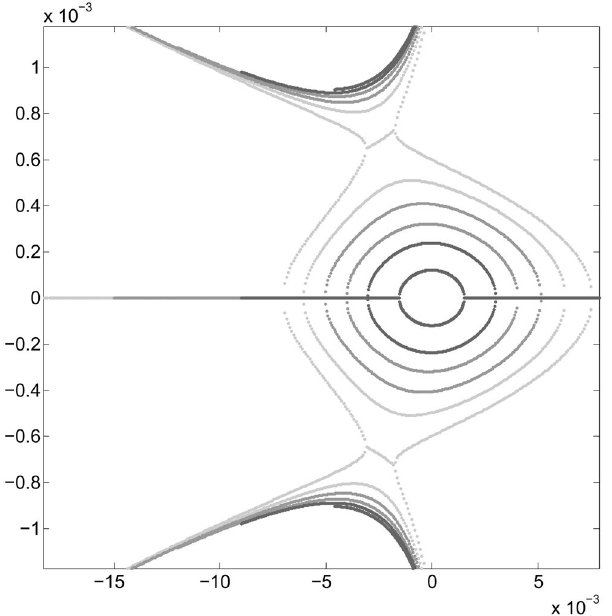
Figure 7. Phase space ( x , p x ) for various oscillation amplitudes x 0 = 1.53, 3, 4, 5, 6, 7 mm. With the new sextupoles { S 1 } , obtained by optimizing to x 0 = 7 mm, the dynamic aperture is explored and it is observed that it increases to ∼ 6 − 7 mm, before tori start to break. For each value of the quasi-invariant, the inner branch and its corresponding outer branch are plotted in the same grayscale color. Units in the plot are m-rad.